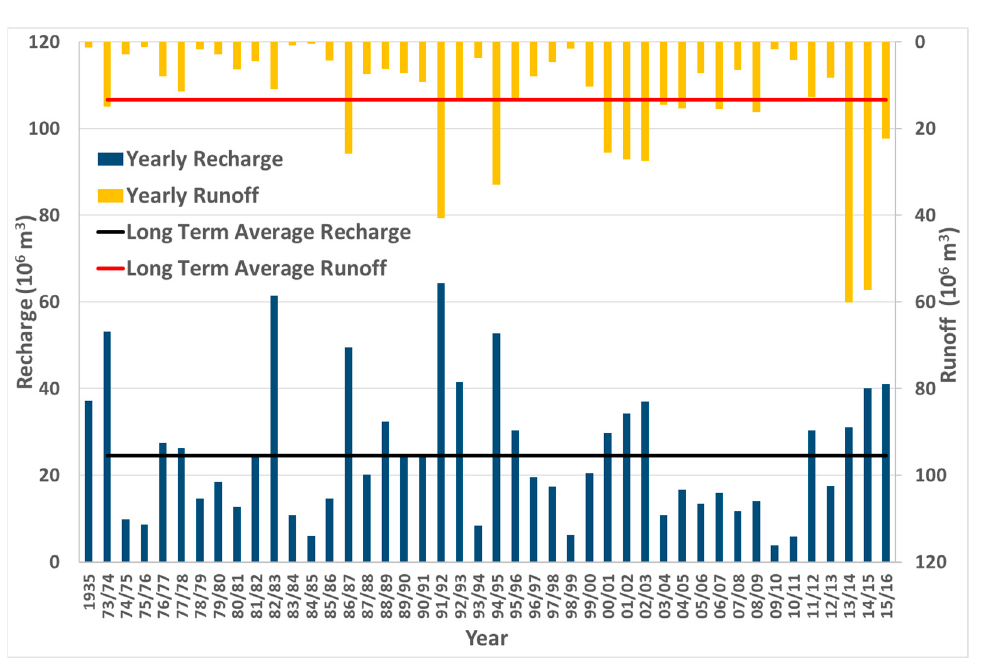
Figure 4. Runoff and recharge results (1935 and 1973–2016).